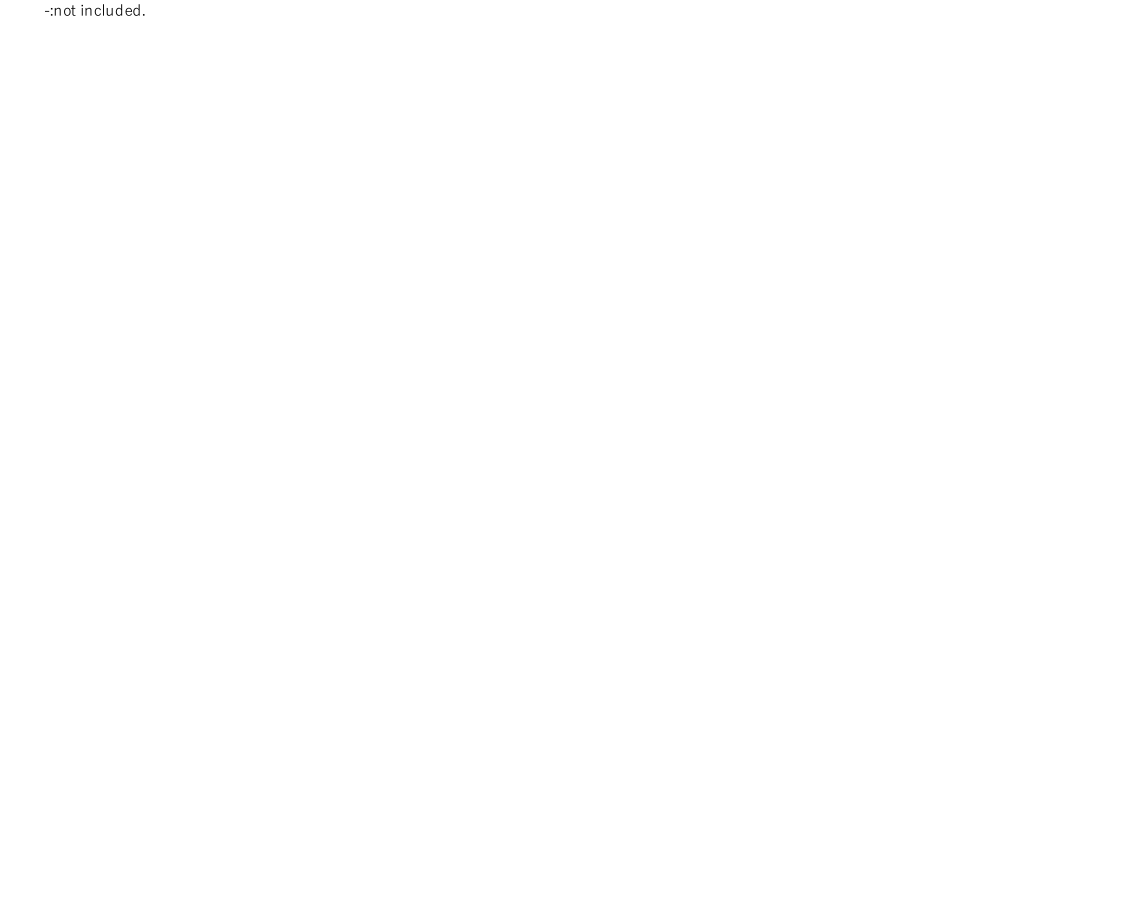
A72-L Consciousness of local knowledge A73-T Diversity of traditional knowledge A74-L Diversity of local